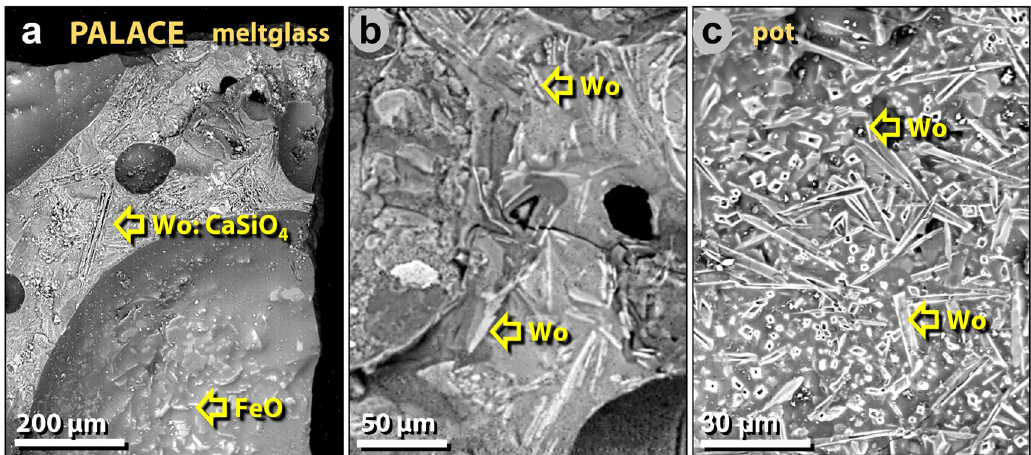
Figure 43. SEM images of wollastonite crystals in palace melted pottery and mudbricks. ( a ) Spindle-like crystals of wollastonite (CaSiO 4 ) on the broken face of mudbrick meltglass. Crystals of iron oxide line the vesicle. ( b ) Wollastonite crystal within the meltglass matrix. ( c ) Wollastonite crystals within a vesicle of melted